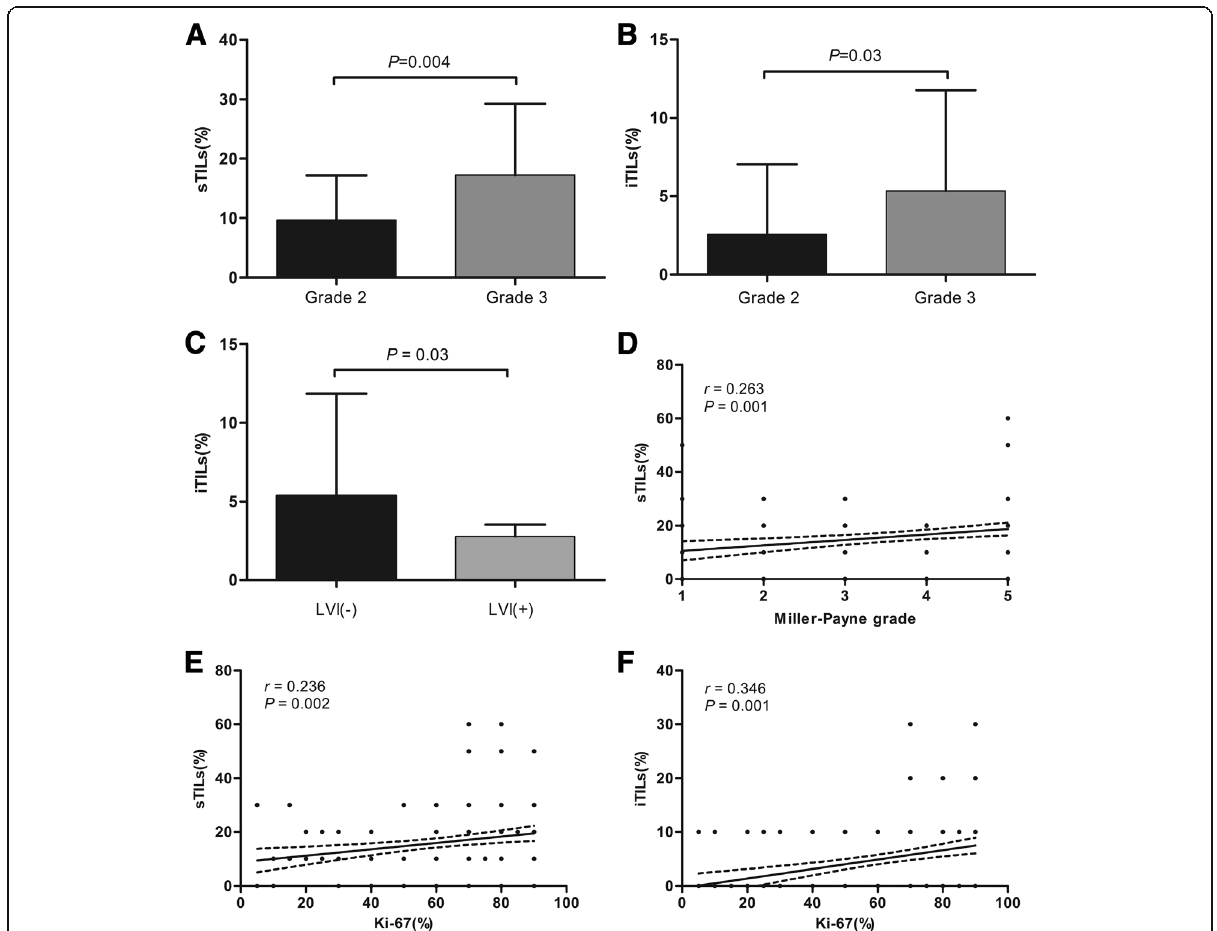
Fig. 2 The correlations of TILs with histological grade, LVI, Miller-Payne grade and Ki-67 index in TNBCs. Y axis represented the scores of TILs; X axis represented histological grade (2 or 3), LVI ( − /+), Miller-Payne grade (1 – 5) or Ki-67 index (%). a and b : Both sTILs and iTILs were positively associated with histological grade (sTILs: P = 0.004; iTILs: P = 0.03). c : ITILs were positively correlated with negative lymphovascular invasion ( P = 0.03). Dots corresponded to the scores of TILs and whiskers corresponded to its Standard Error. Red line corresponded to the mean scores of TILs. d: STILs was positively correlated with Miller-Payne grade ( r = 0.263, P = 0.001). e and f : STILs and iTILs scores were positively associated with Ki-67 index (sTILs: r = 0.236, P = 0.002; iTILs: r = 0.346, P = 0.001). LVI: lymphovascular